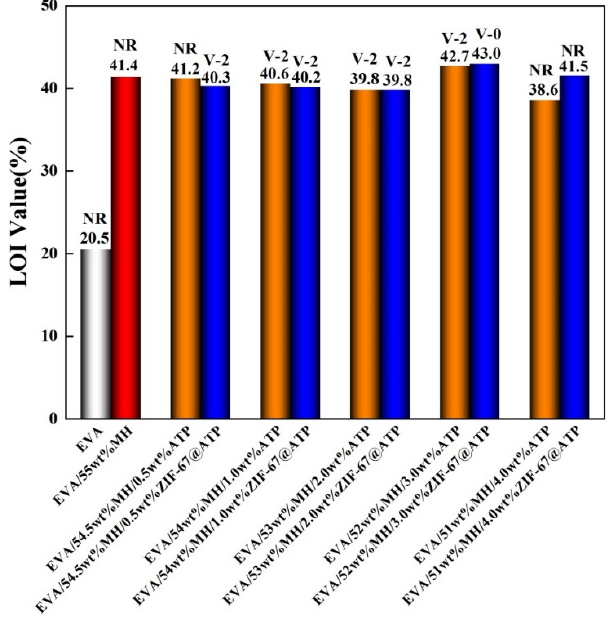
Figure 4. LOI and UL-94 results for EVA and EVA composites.